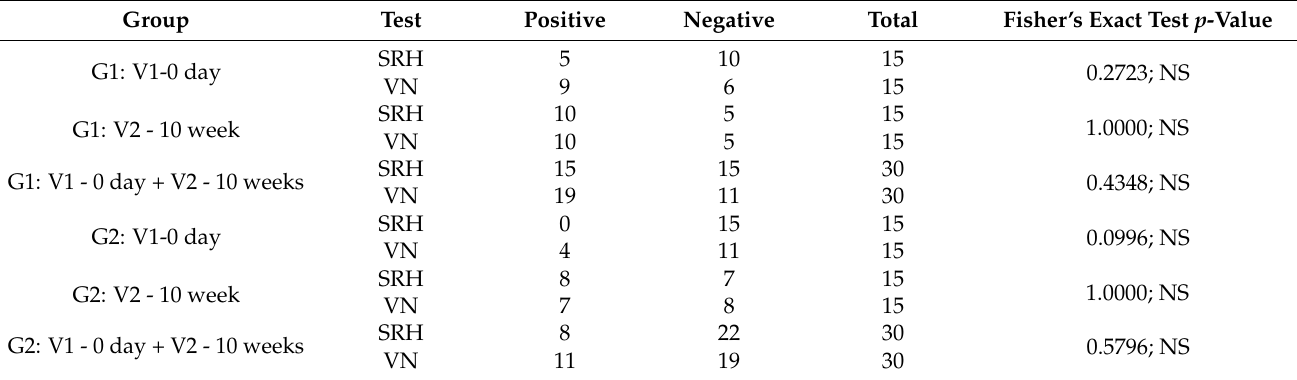
Table 2. Detection of EIV